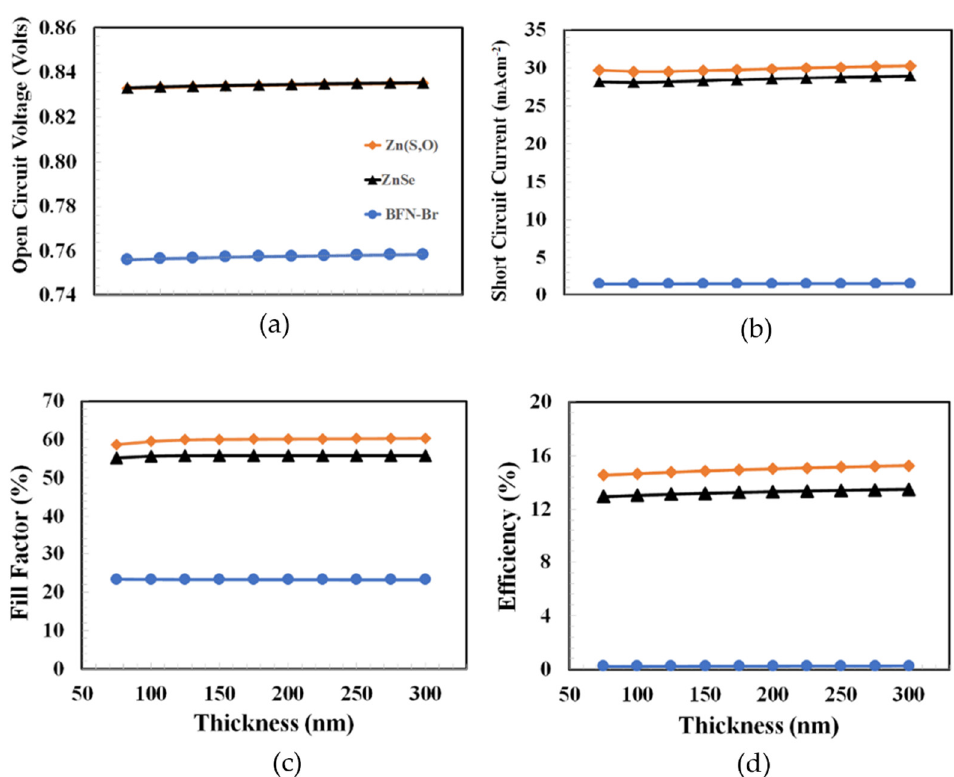
Figure 3. Shows the photovoltaic parameters of ( a ) open-circuit voltage, ( b ) short-circuit current, ( c ) fill factor, and ( d ) power conversion efficiency as a function of PEDOT:PSS thickness for ITO/Zn(O,S)/PTB7:PC 70 BM/PEDOT:PSS/Au, ITO/ZnSe/PTB7:PC 70 BM/PEDOT:PSS/Au, ITO/PFN-Br/PTB7:PC 70 BM/PEDOT:PSS/Au, respectively.